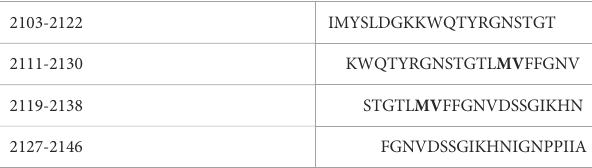
TABLE 1 FVIII peptides spanning the F8 exon 22-23 junction